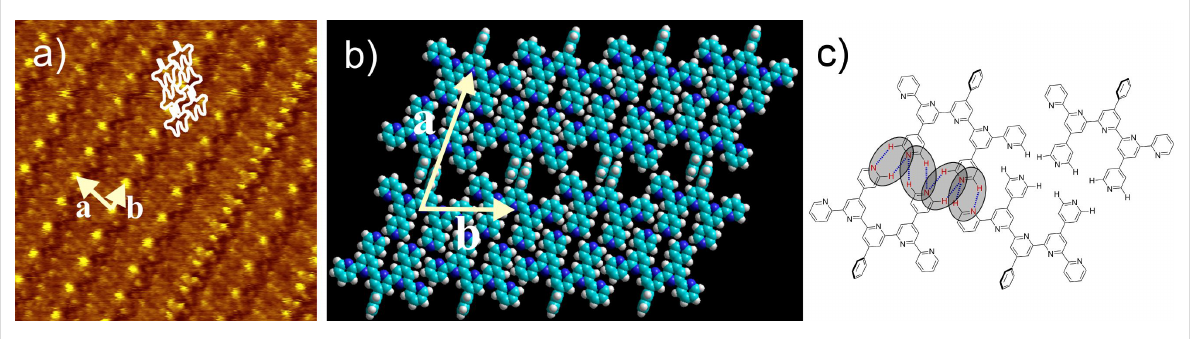
Figure 11: a) 15 × 15 nm 2 STM image ( I set = 23.5 pA, V set = − 580 mV) of 2,4'-PhSpPy ( 12 ) at the HOPG/TCB interface [ a = 2.4 ± 0.2 nm, b = 1.5 ± 0.2 nm, a,b = 77 ± 2°] with six overlaid molecules; b) model of the 2,4'-PhSpPy ( 12 ) lamellar pattern; c) hydrogen bonding motif of 2,4'-PhSpPy ( 12 ); the hydrogen bonds are marked by